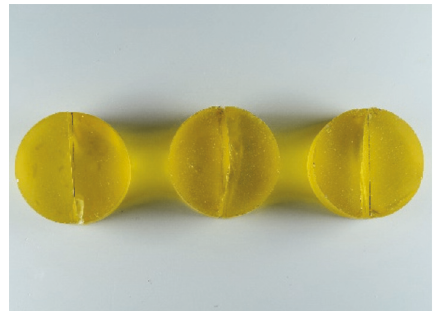
Figure 7: Transparent rock specimens with 6%